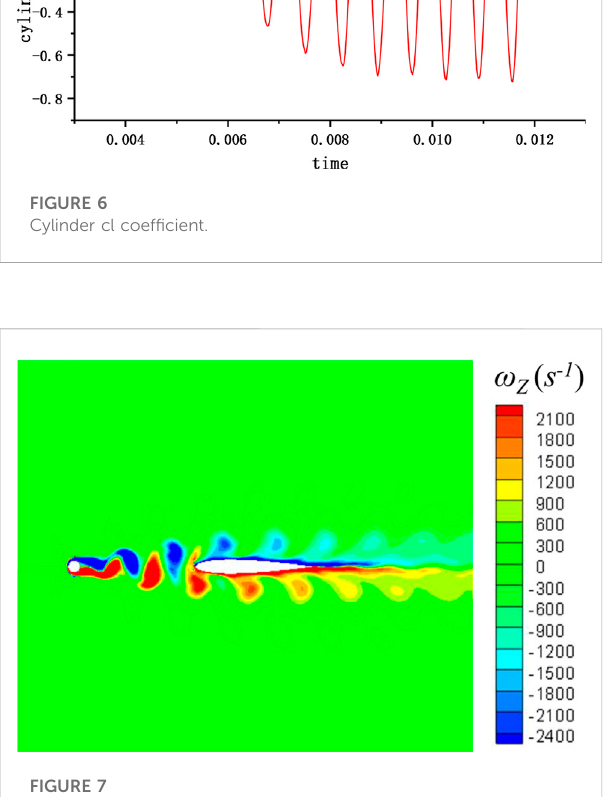
FIGURE 7 z -direction partial vorticity